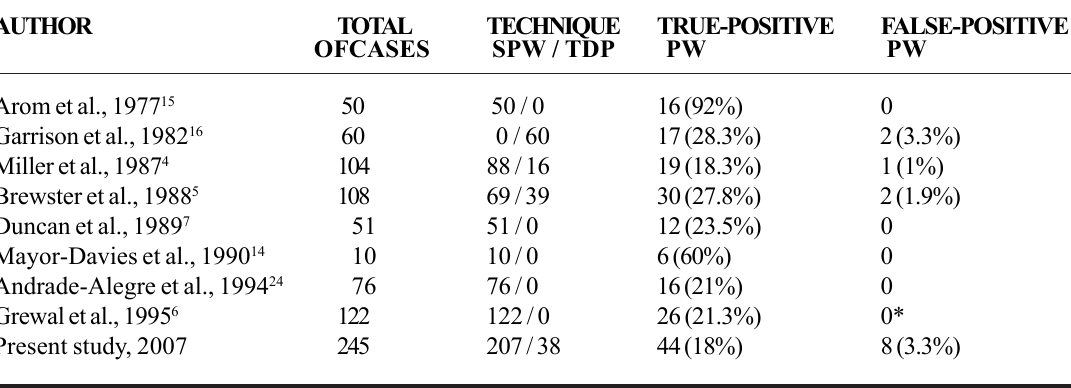
TABLE 4 - Comparison between our results and the